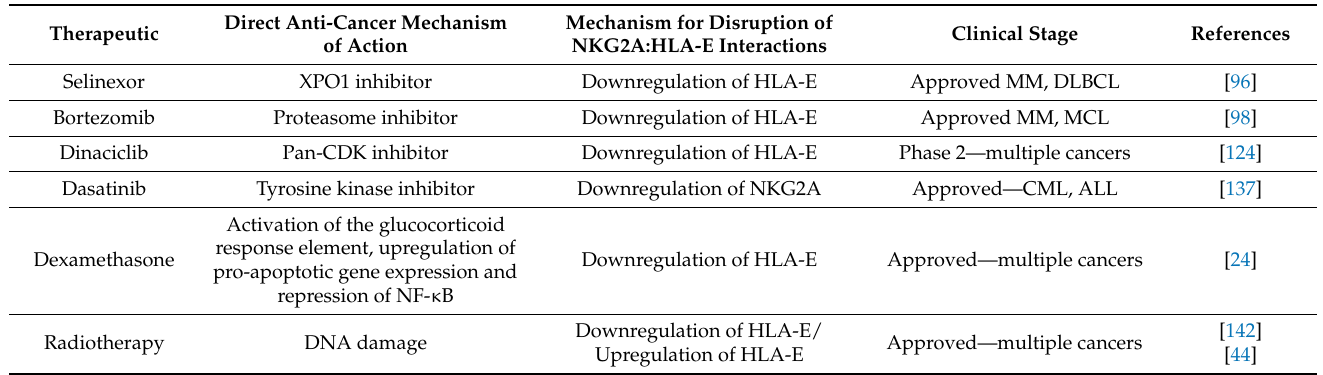
Table 2. Indirect targeting of